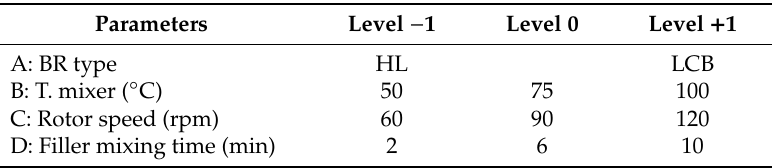
Table 4 . Experimental design for optimizing mixing conditions . Table 4. Experimental design for optimizing mixing conditions.